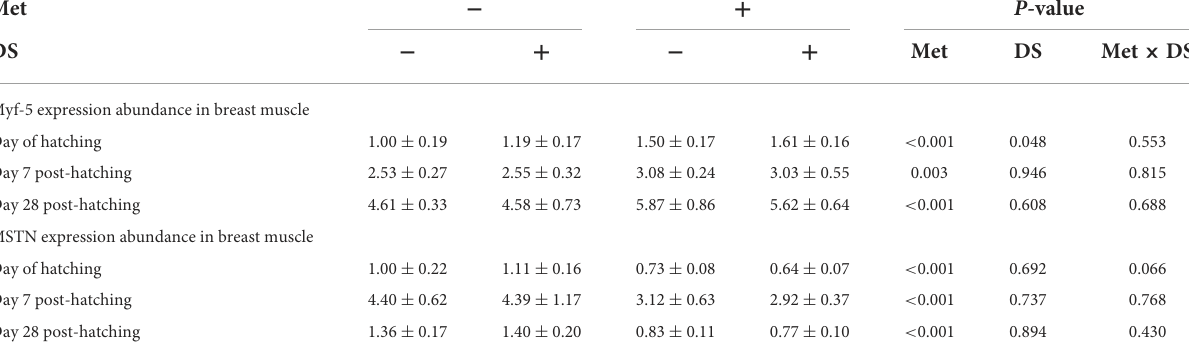
TABLE 7 Effects of in ovo injection of methionine (Met) and disaccharide (DS) on the expression of myogenic factor-5 (Myf-5) and myostatin (MSTN) from breast muscle of geese during the early-life post-hatching a,b . Met